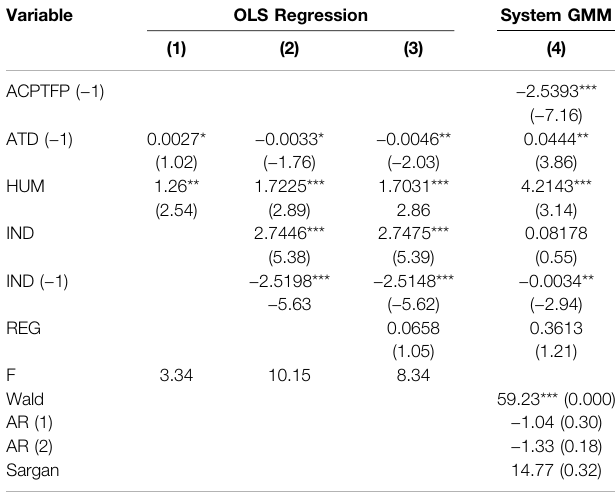
TABLE 4 | Results of multiple regression models. Variable OLS